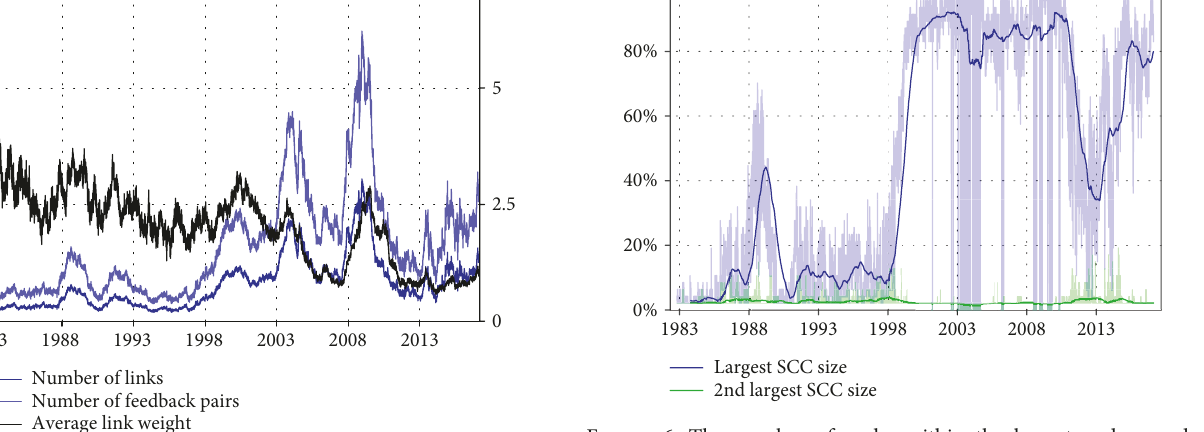
Figure 6: The number of nodes within the largest and second largest strongly connected components of the networks, expressed as a percentage of all the nodes in the network. The transparent lines are the raw data and the full blue and green lines correspond to the 1-year moving